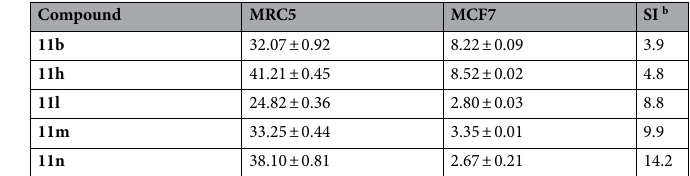
Table 2. In vitro antiproliferative effects (IC 50 , µM) of 11b, 11h, 11l, 11m, 11n against MCF-7 and MRC5 cell lines a . a Values were the means of three replicates ± standard deviation (SD). b SI = Selectivity Index = IC 50 value normal cell/IC 50 value cancer